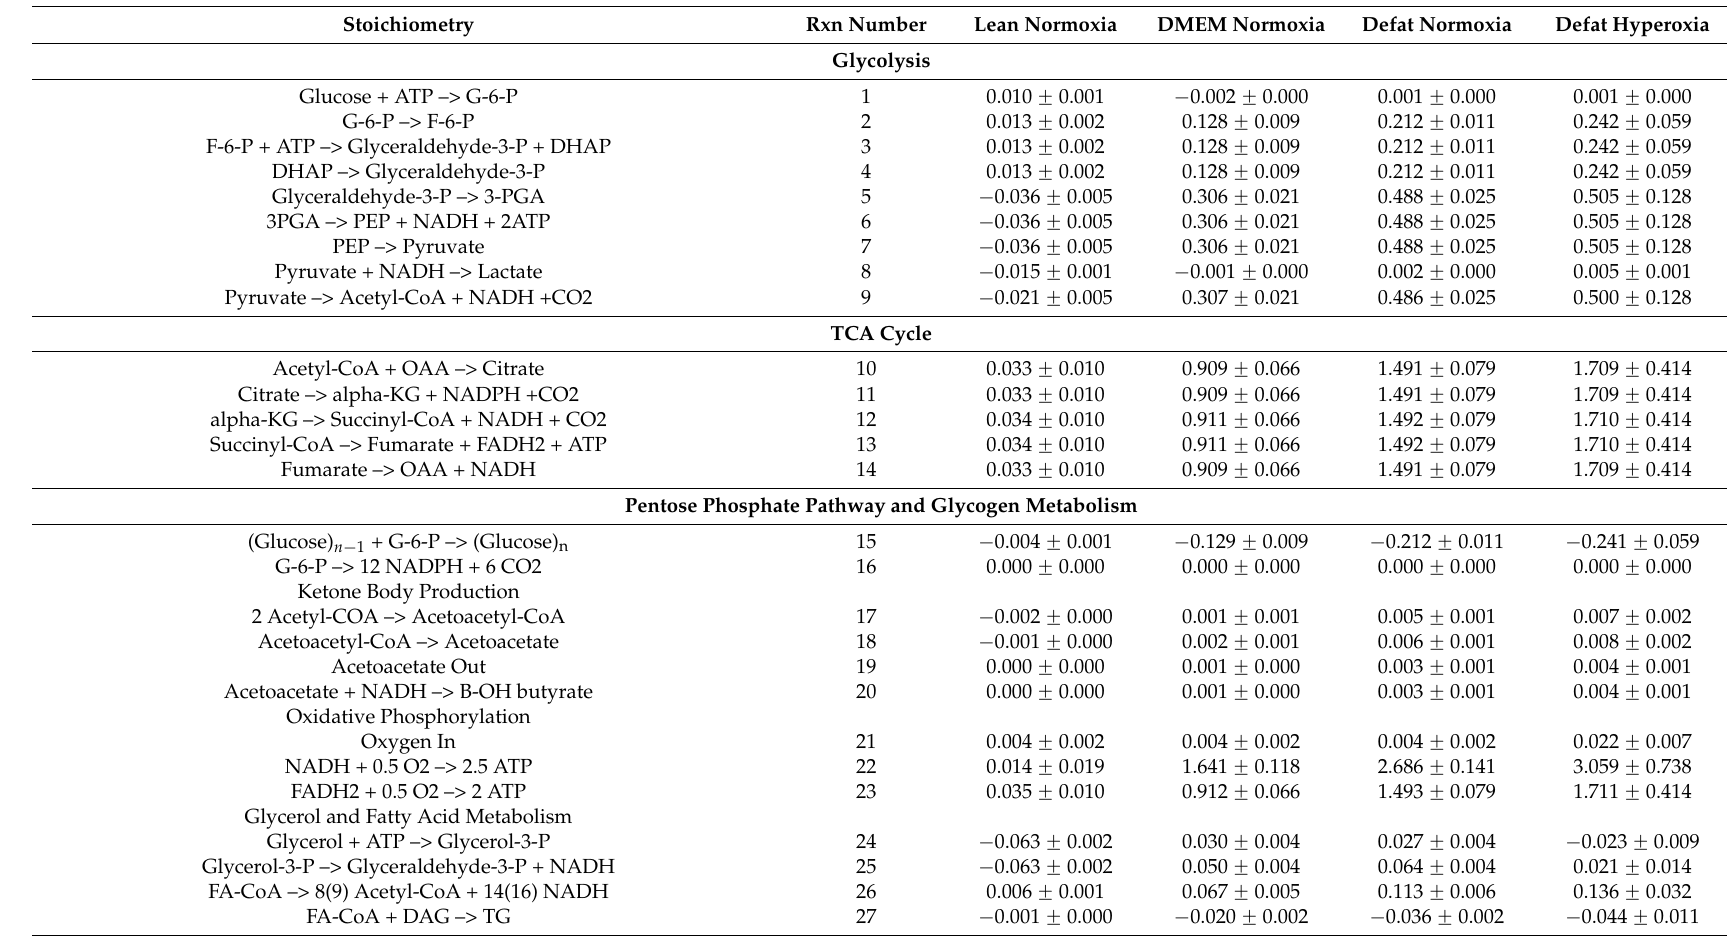
Table 2. Calculated flux distribution during defatting period ( µ mol/10 6